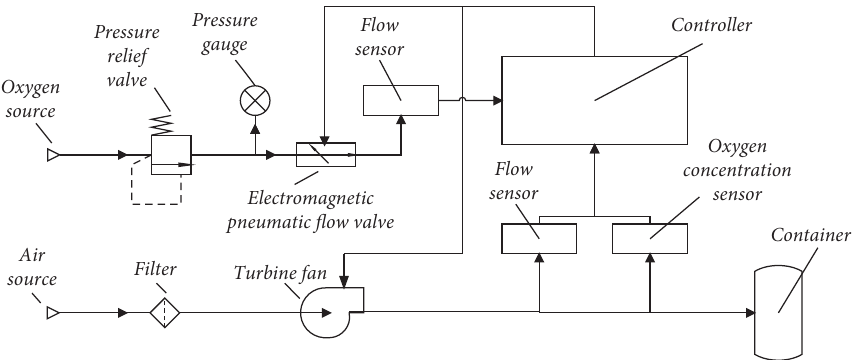
Figure 1: New structure of high flow nasal oxygen therapy